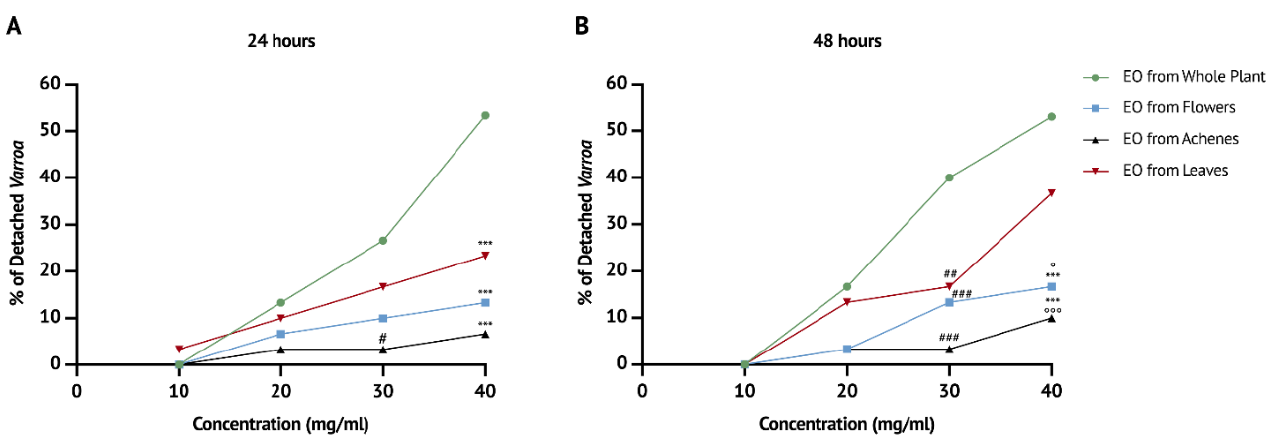
Figure 3. Mortality percentages reached after ( A ) 24 h and ( B ) 48 h of exposure to EO vapours. *** p < 0.001 vs. EO from whole plant 40 mg/mL; # p < 0.05, ## p < 0.01, ### p < 0.001 vs. EO from whole plant 30 mg/mL; ° p < 0.05; °°° p < 0.001 vs. EO from leaves 40 mg/mL. Table 4. Detachment percentages registered after 24 and 48 h of exposure to EO vapours.